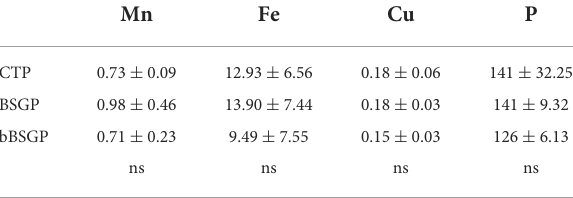
TABLE 4 Micronutrients and phosphorous content expressed as mg kg − 1 of escarole leaves grown in soil unamended (CTP) and amended with native (BSG) or bioprocessed brewers’ spent grain